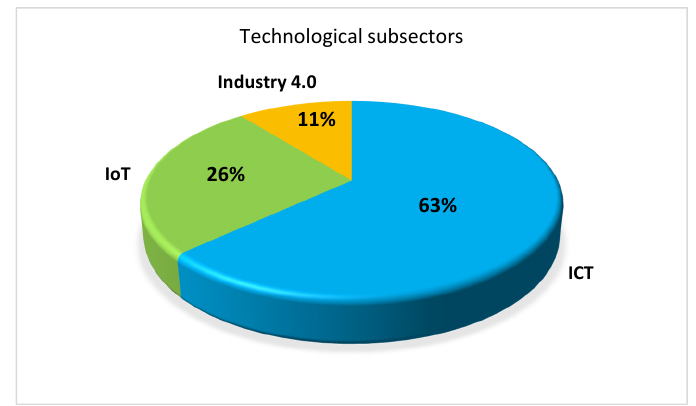
Figure 6. Proportions between solutions in different technological subsectors.